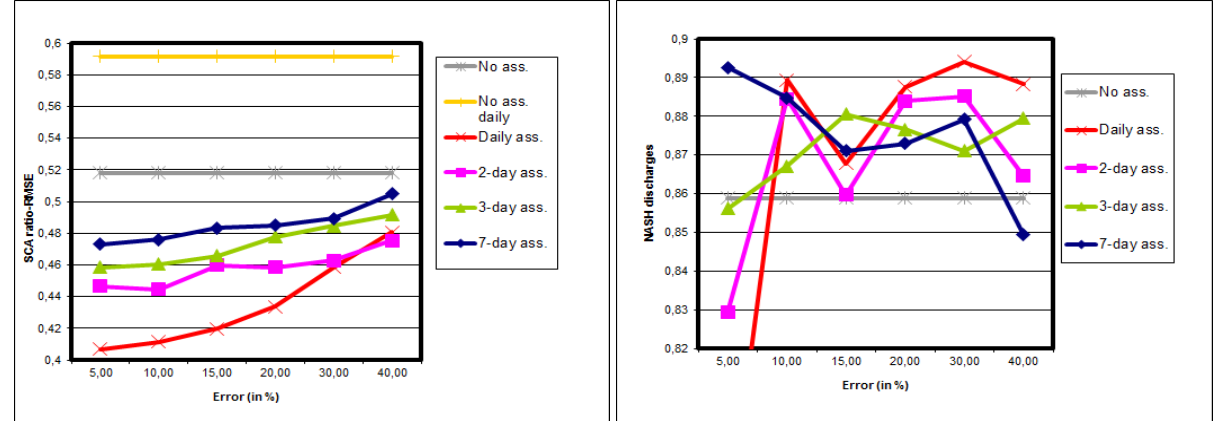
Figure 5. SCA ratio-RMSE ( left ) and Nash ( right ) for the real MODIS SCA particle filter experiments on the area upstream of the Kromericz station with 50 particles. The SCA proxy (not plotted) has a ratio-RMSE of 0.51 compared with the composite MODIS and 0.50 compared with the daily MODIS; the proxy discharges have a Nash of 0.85.